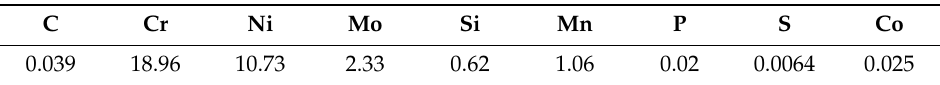
Table 3. Chemical composition of E316L(wt.%).